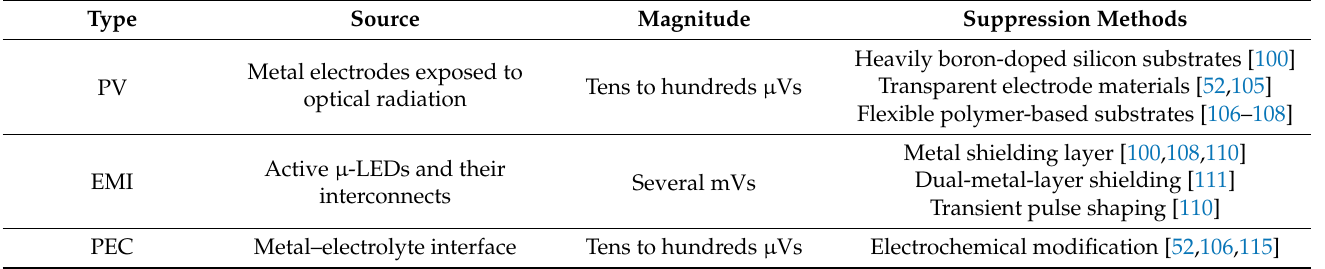
Table 1. Comparison of three types of optical-stimulation-induced